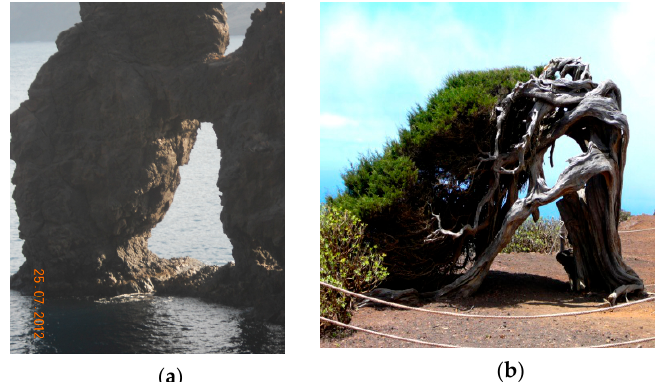
Figure 2. El Hierro UNESCO Biosphere Reserve: ( a ) Roque de la Bonanza, ( b ) juniper tree at El Sabinar under the influence of strong wind. Photo: G. Jastrz ę bska.